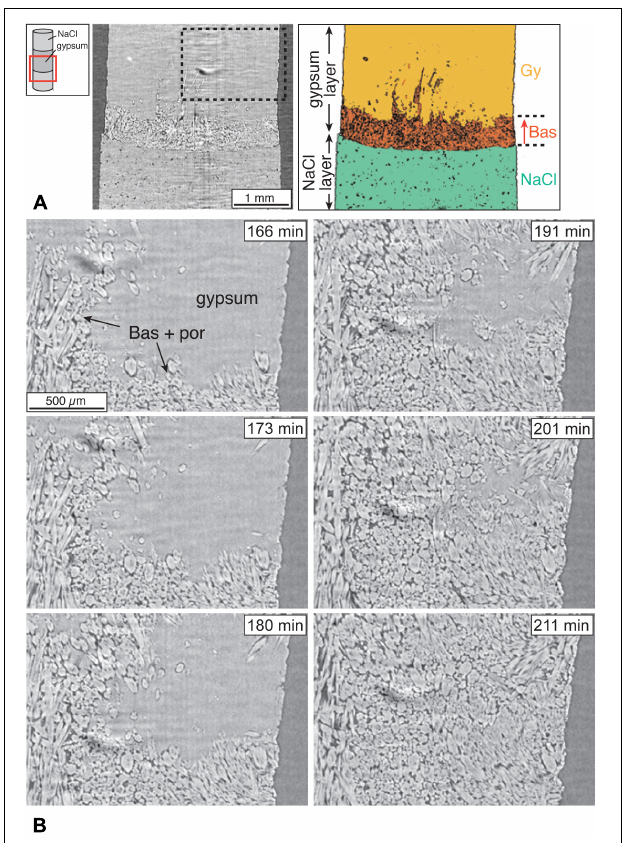
FIGURE 6 | Microstructural development overview. (A) Left: sketch of sample assembly with indicated FOV, which captures the interface between an upper gypsum and a lower NaCl layer. Middle: tomographic reconstruction. Vertical slice through the sample. Right: Same as middle image, but segmented for the different phases for better visibility. Orange: Gypsum, Red: Bassanite, Green: NaCl. The dehydration reaction, forming bassanite, initiates at the gypsum – NaCl interface and travels upwards into the gypsum layer. (B) Time-series showing the advance of the dehydration reaction.